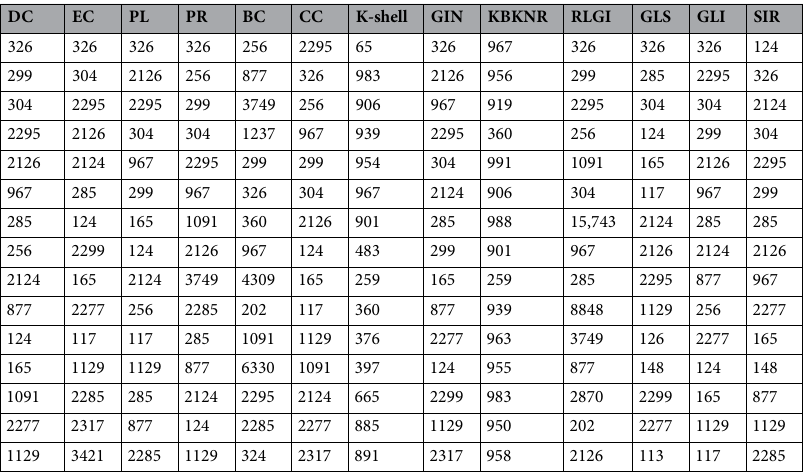
Table 9. Top-15 nodes in the Ca-Astroph network obtained by different